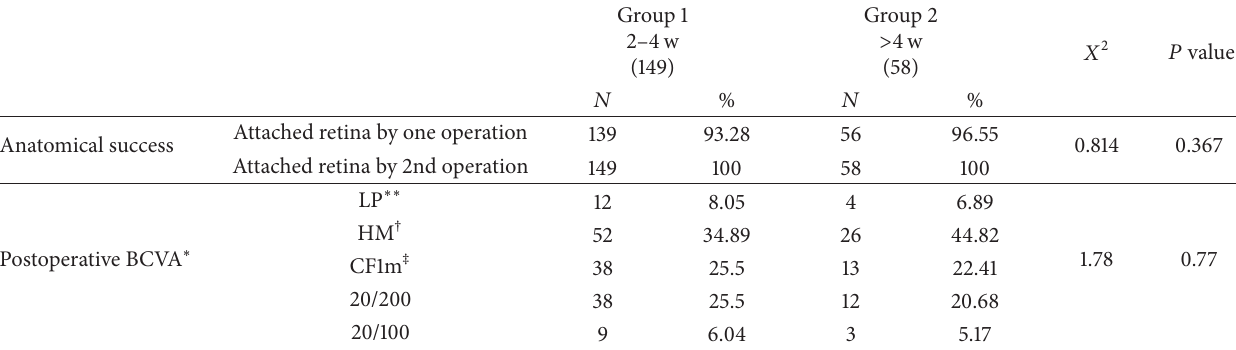
∗ BCVA: best corrected visual acuity. ∗∗